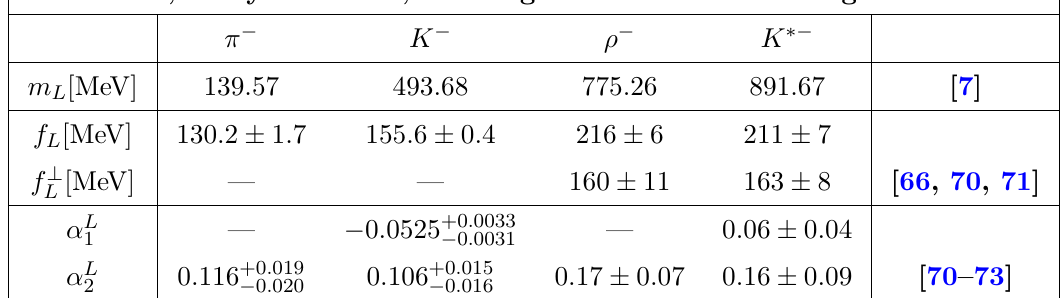
Table 1 . Summary of the theoretical input parameters used throughout this paper. The values of the CKM matrix elements are taken from the CKMfitter tree-only fit results as of Summer 18 [64, 65]. The transverse decay constants f ⊥ and f ⊥ are given at the scales 1 . 27 GeV [68] L D ( ∗ )+ s and 1 GeV [71], respectively. The Gegenbauer moments of light pseudoscalar and vector mesons are evaluated at µ = 2 GeV and µ = 1 GeV ,